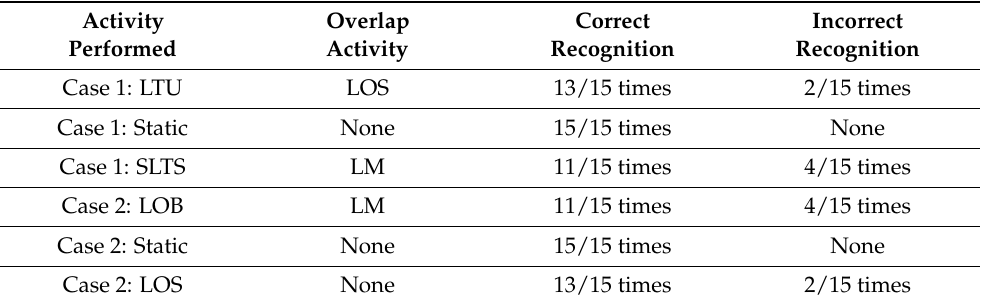
Table 1. Activities performed, overlap, and recognition findings summary for Cases 1 and